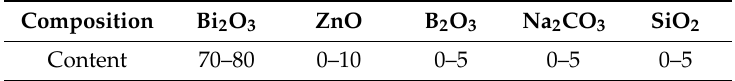
Figure 2. Macro morphology and microstructure of the brazing filler glass powder. Table 1. Chemical compositions of the brazing filler glass powder (in wt.%).